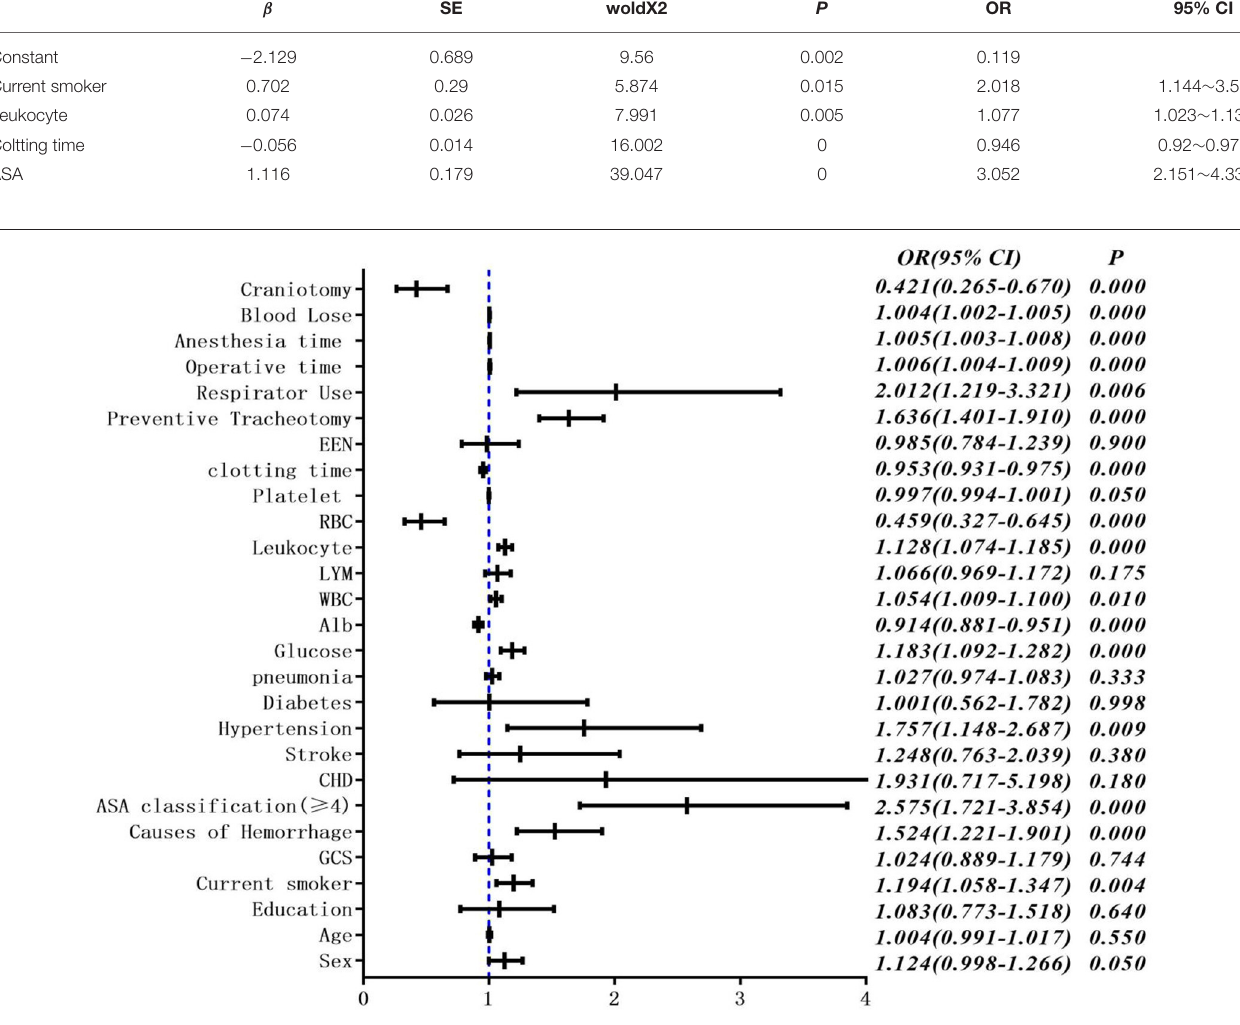
FIGURE 2 | Multivariate unconditional logistic regression analysis and forest map of postoperative pulmonary